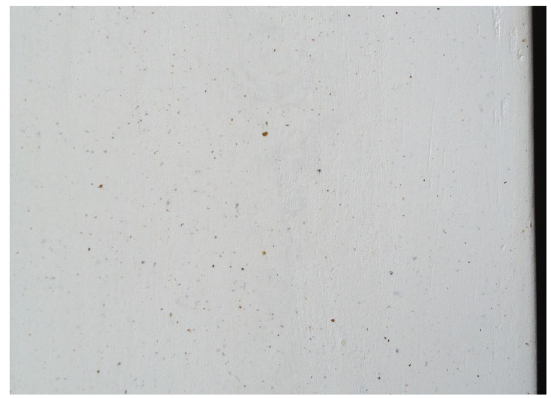
Fig. 22 Ludwig Mies van der Rohe and Lilly Reich, House Tugendhat, Brno, 1930, bedroom Fritz Tugendhat, 2011 reconstructed ‘ stucco lustro ’ (preservation by covering) (Source: Ivo Hammer 2013)